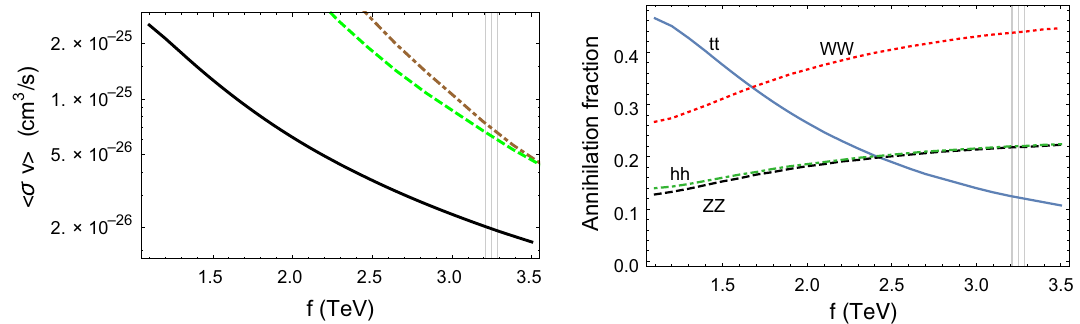
ηη → W + W − . Right panel annihilation fraction of the main channels fortwo-bodyfinalstates; t ¯ t ( bluecontinuousline ), W + W − ( reddotted ), hh ( green dot-dashed ) and Z Z ( black dashed ). Other (subdominant) channels are not shown. As in previous plots, the vertical gray lines indicate the range of values of f corresponding to the observed DM abundance at 95%